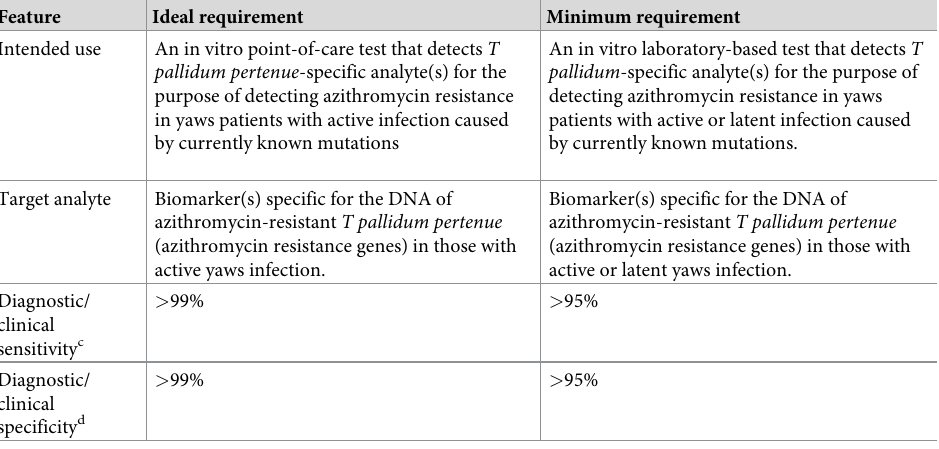
Table 2. Select characteristics of needed test for detection of azithromycin-resistant